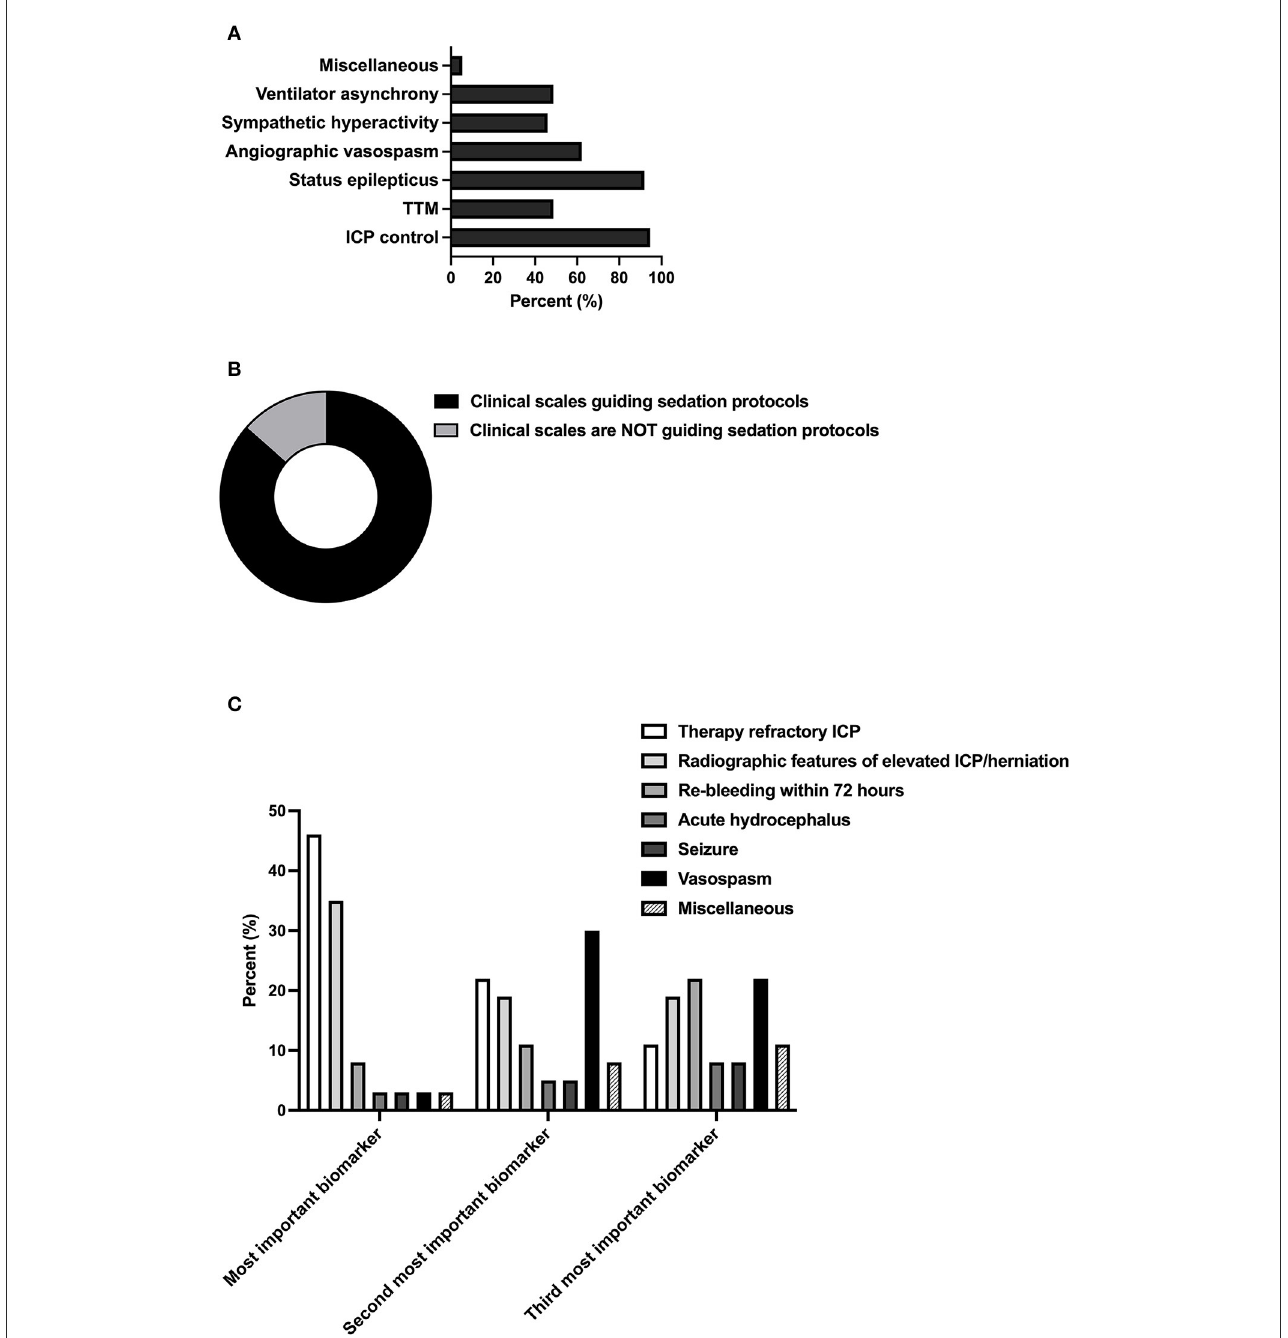
FIGURE1 Indications and relevant biomarkers for prolonged sedation. (A) Relevance of SAH grading scales (World Federation of Neurological Surgeons (WFNS), Hunt and Hess, modified Fisher scale) to the guidance of sedation protocols [ (B) ; n = 37; multiple selection of items]. Indications for prolonged sedation of patients in neurointensive care. Miscellaneous included non-neurointensive care-specific indications (pneumonia, sepsis) [ (C) ; n = 37]. Ranking of predefined biomarkers according to their impact on the guidance of sedation protocols. Miscellaneous included ongoing refractory ICP elevation ( n = 1, most important biomarker), reduction in brain tissue oxygen tension (PtbO2) monitoring ( n = 2, second most important biomarker) as well as vegetative dysregulation, overall clinical impression, and no relevant other biomarkers ( n = 2 and n = 1, respectively). TTM, targeted temperature management, ICP, intracranial